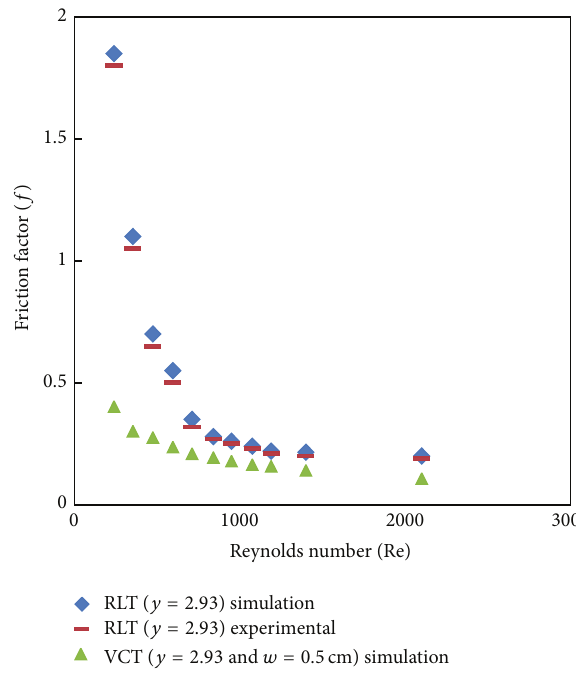
Figure 13: Simulated friction factor of V-cut twisted tape and RLT